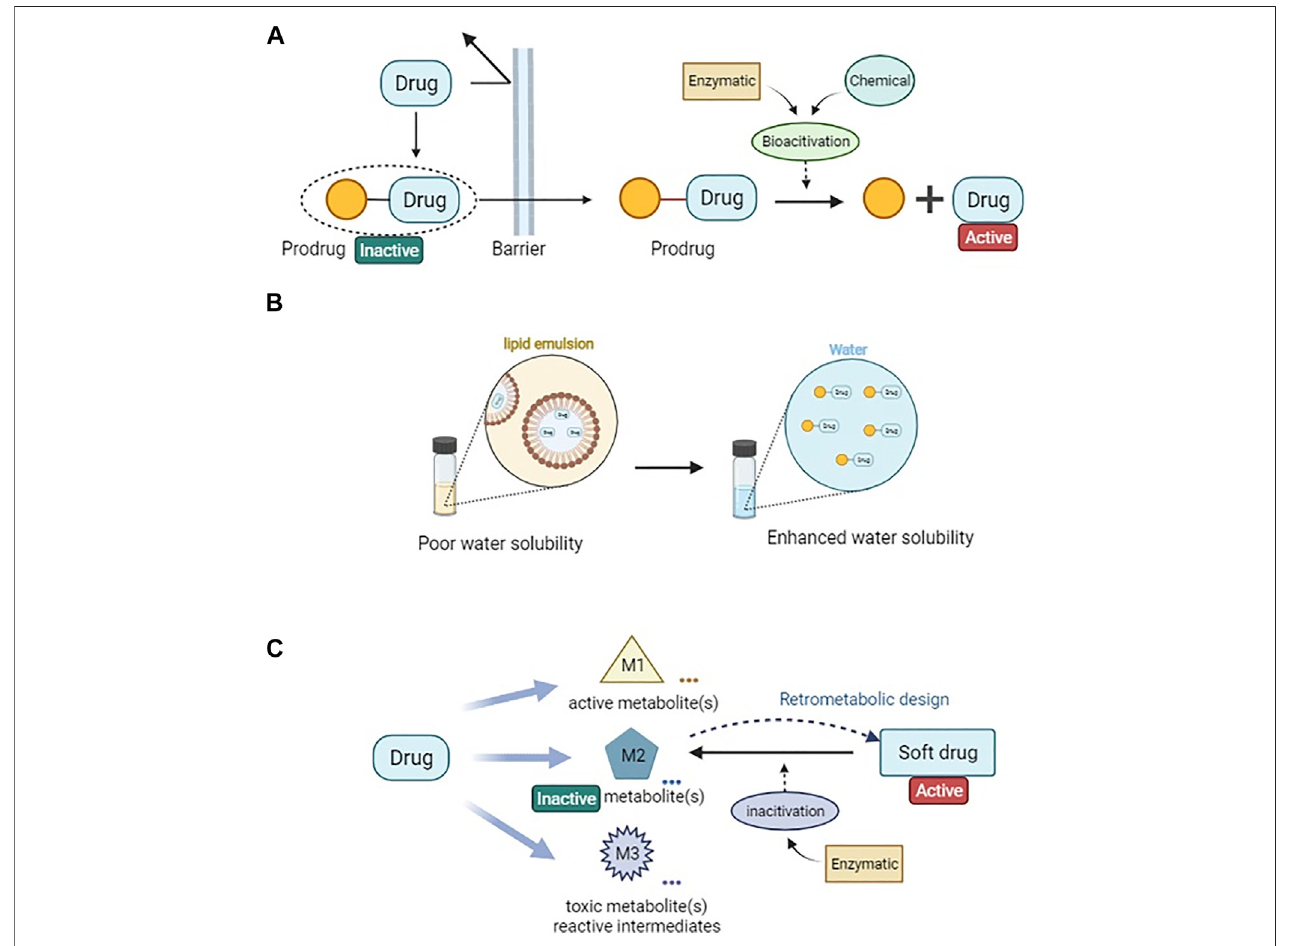
FIGURE 1 | Drug metabolic and pharmacokinetic optimization strategies via prodrug and soft drug approach. (A) A simpli fi ed illustration of prodrug design for enhanced permeability. (B) Prodrug design for improving drug solubility. (C) A general sheme of soft drug design loop.